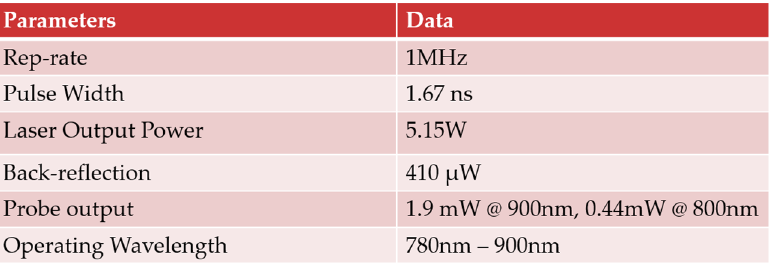
Figure 24. Measured system performance parameters for cart-based SCISCCO prototype.